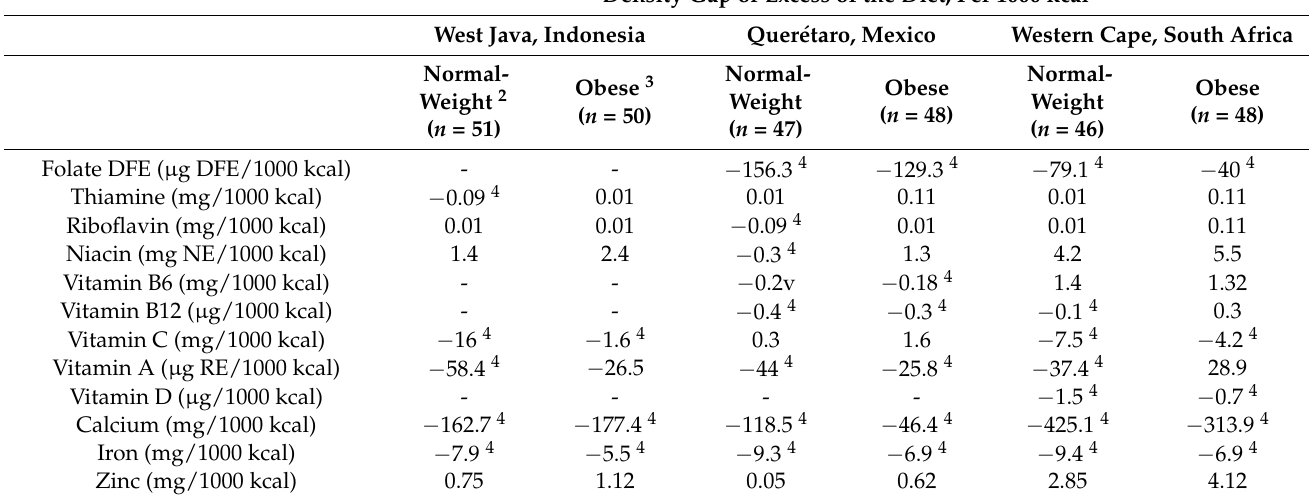
Table 5. Micronutrient density gap or density excess of the diets, in units per 1000 kcal, by survey area for normal-weight vs. obese women.